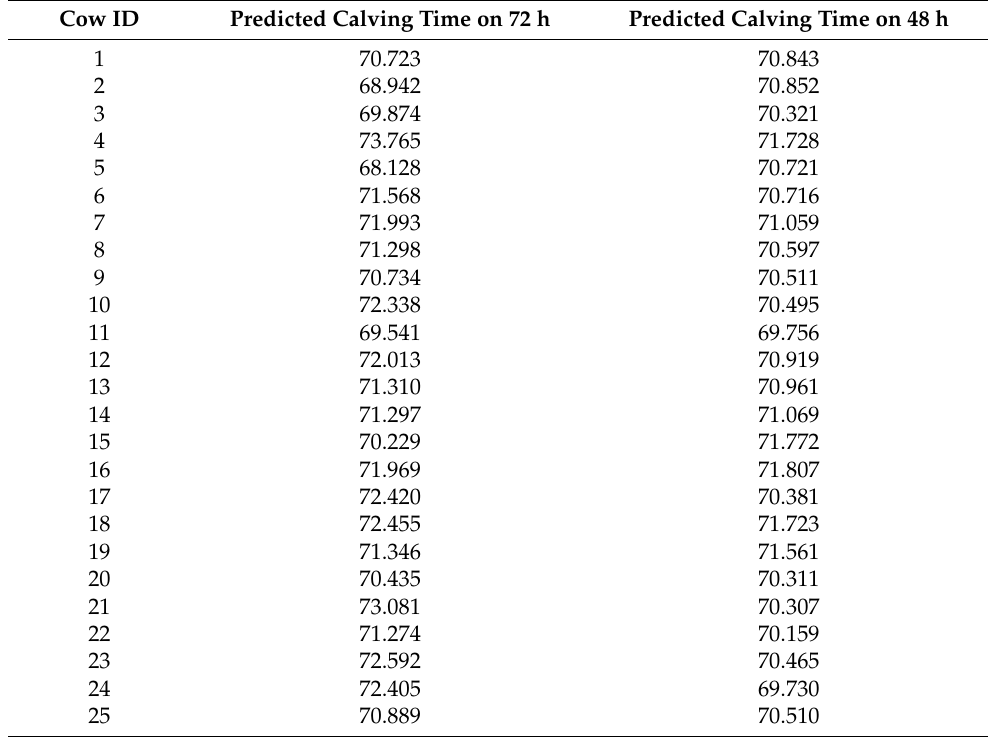
Table 4. Experimental results of cows predicted calving time based on 72 h data and 48 h data before calving event occurs.